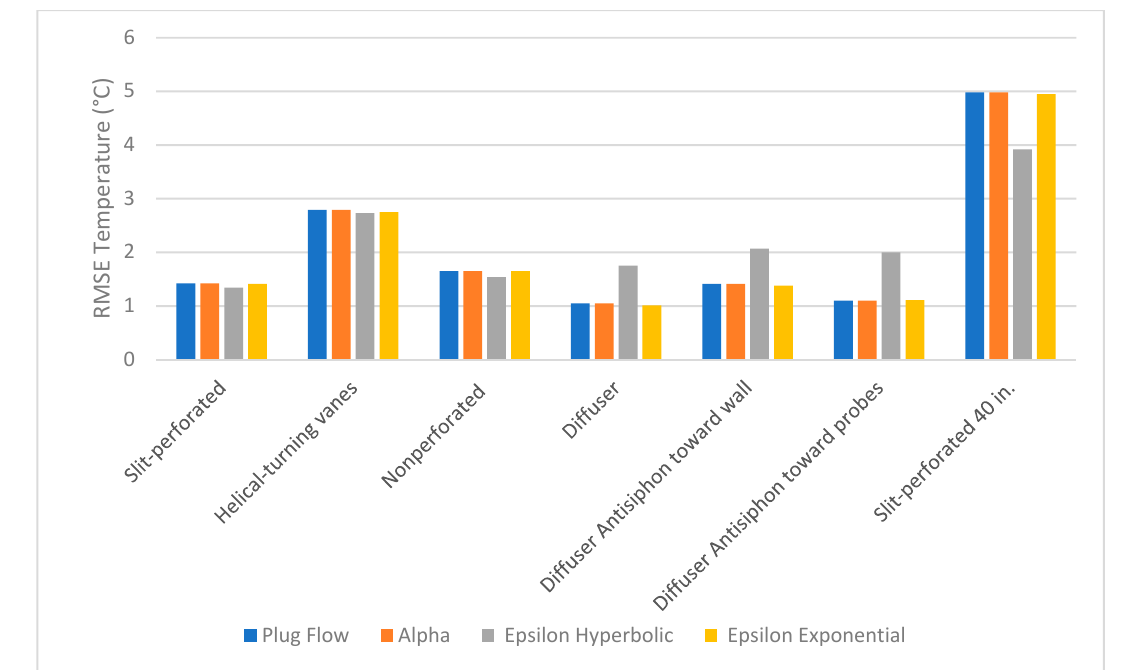
Figure 10. Discharging results for a 75% charged draw experiment. All flows were nominally 1.7 GPM, and tubes were 53 in. long unless listed otherwise.